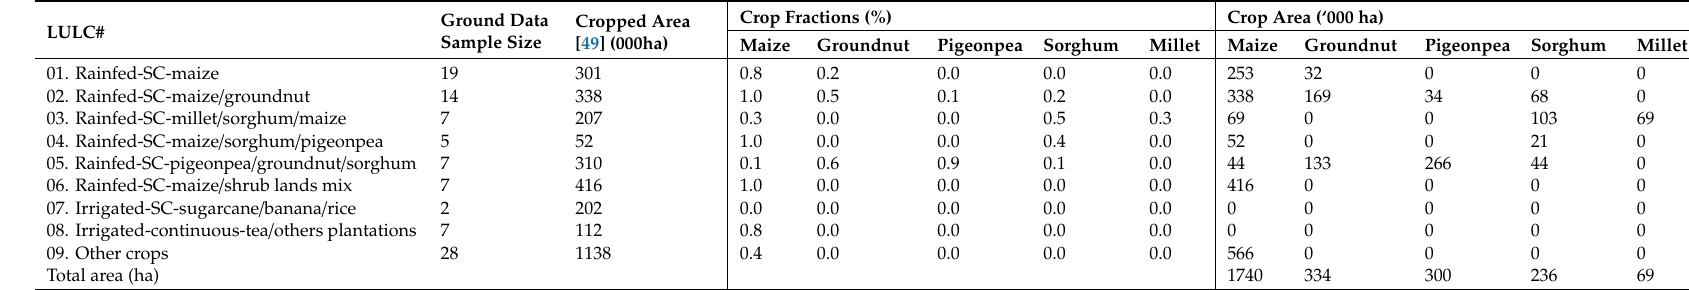
Table 3. Cropland area for each class, providing an understanding of sub-pixel fractions for the five important crops in Malawi for the crop year 2010–2011.